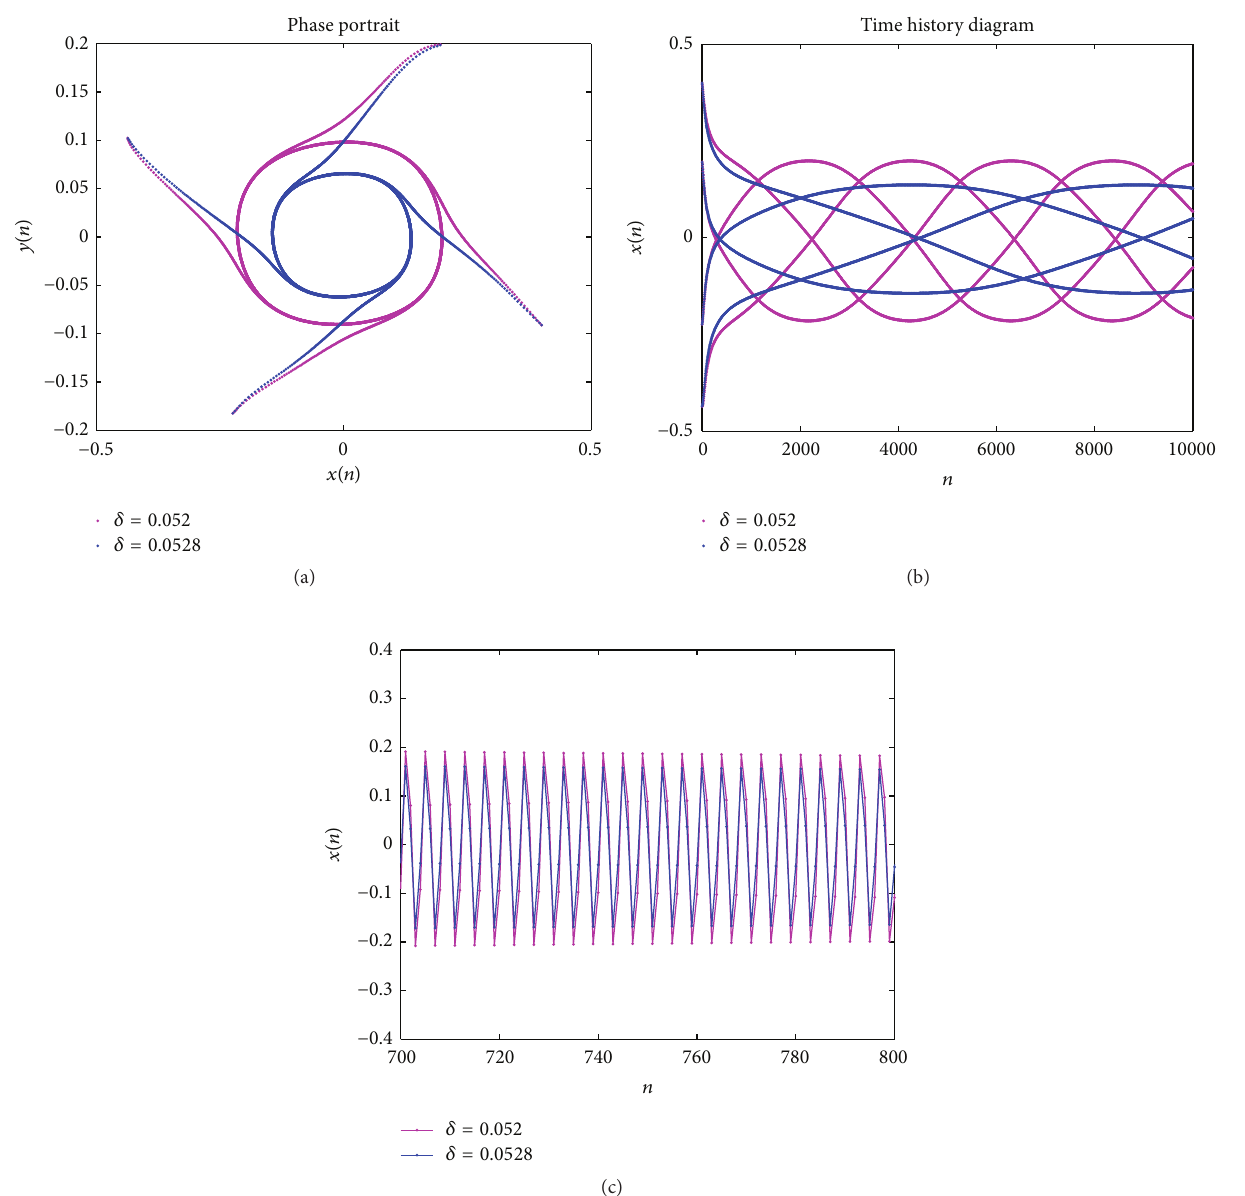
Figure 8: (a) Phase portrait and (b) time history diagram of stochastic discrete-time hyperchaotic system (6) with 𝛿 = 0.052 and 𝛿 = 0.0528 . (c) Local amplification corresponding to